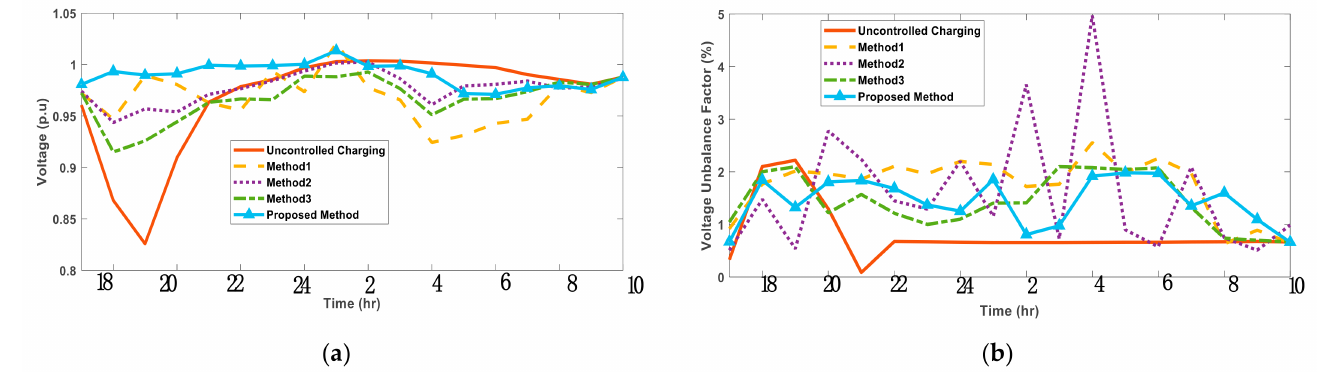
Figure 15. Bus 846 ( a ) voltage and ( b ) VUF for price signals in the spring season.